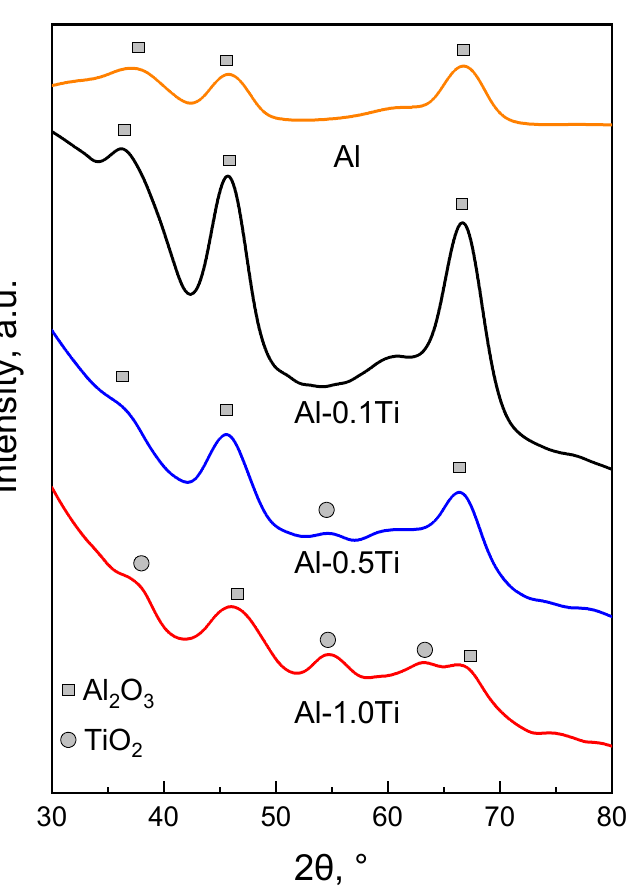
Figure 5. XRPD of the oxide supports.